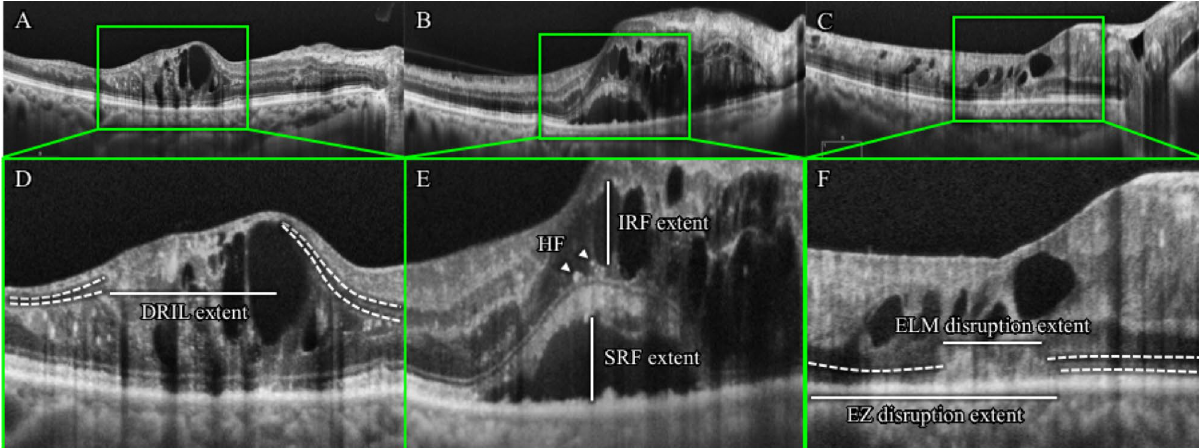
Figure 2. Optical coherence tomography (OCT) B-scan images. ( A , D ) The representative image in which disorganization of retinal inner layer (DRIL) existed is shown. The dashed line shows the range where the ganglion cell layer (GCL)/inner plexiform layer (IPL)-inner nuclear layer (INL) and INL-outer plexiform layer (OPL) interface could be confirmed. ( B , E ) A representative image in which intraretinal fluid (IRF), subretinal fluid (SRF), and hyperreflective foci (HF) existed is shown. ( C , F ) A representative image in which external limiting membrane (ELM) and ellipsoid zone (EZ) disruption existed is shown. The dashed line shows the